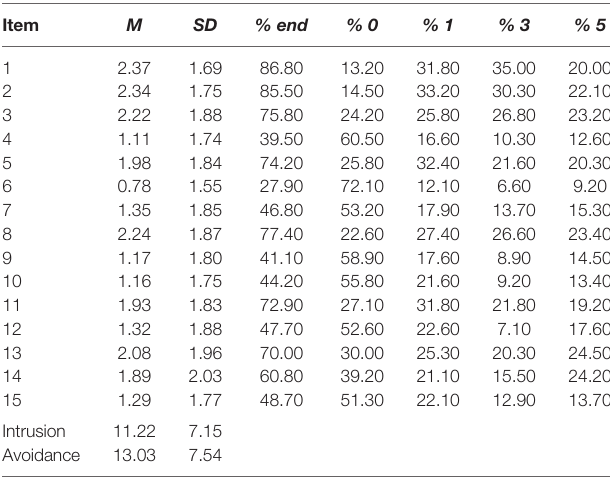
TABLE 1 | Means and Standard Deviations per Item and per Subscale, Percentage Endorsement and Percentage Responses for each Scale Rating point per